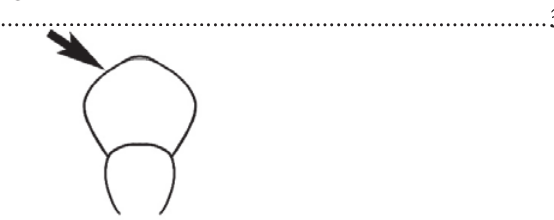
30 Major and minor workers with medial sector of clypeus produced broadly as a flange that projects over the basal half of the mandibles; larger species (HW of large major workers ≥ 3 mm); foreparts light tan or orange to dark crimson (never brown), gaster brown (widespread, mainly arid and semi-arid) ( JDM